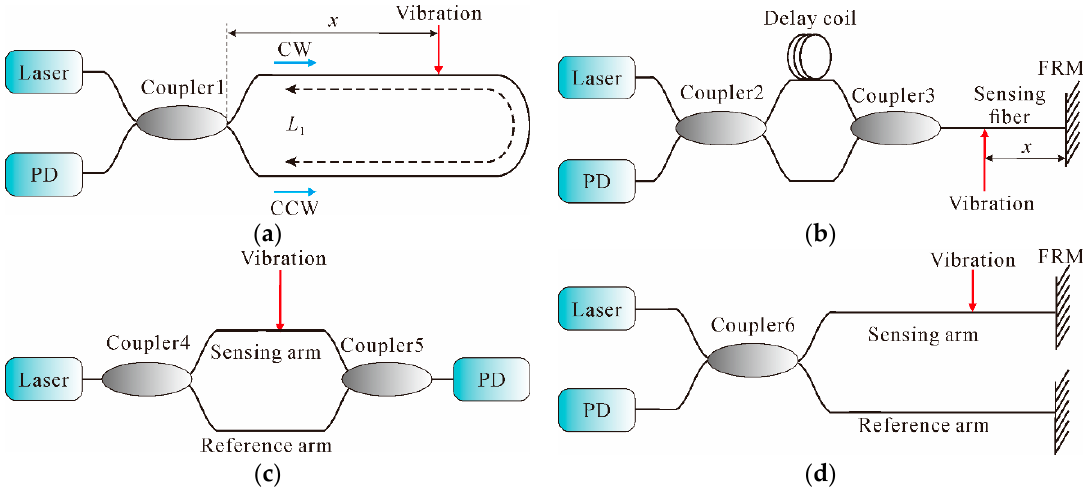
Figure 2. Distributed fiber-optic vibration sensors based on the interferometric technology: ( a ) Sagnac sensors of the loop configuration; ( b ) Sagnac sensors of the in-line configuration; ( c ) MZI sensors; ( d ) MI sensors.